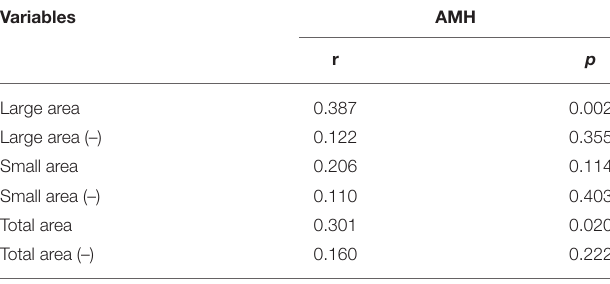
TABLE 3 | Pearson’s correlation (r) for the association between ovary size and blood anti-Müllerian hormone levels and the significance score for each variable (transformed data).